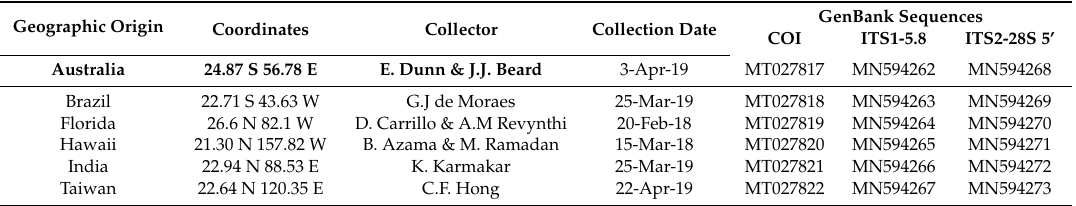
Table 1. Lychee erinose mite ( Aceria litchii ) specimens collected from di ff erent countries and used for DNA fragment sequence analysis. GenBank accession numbers for all analyzed sequences are